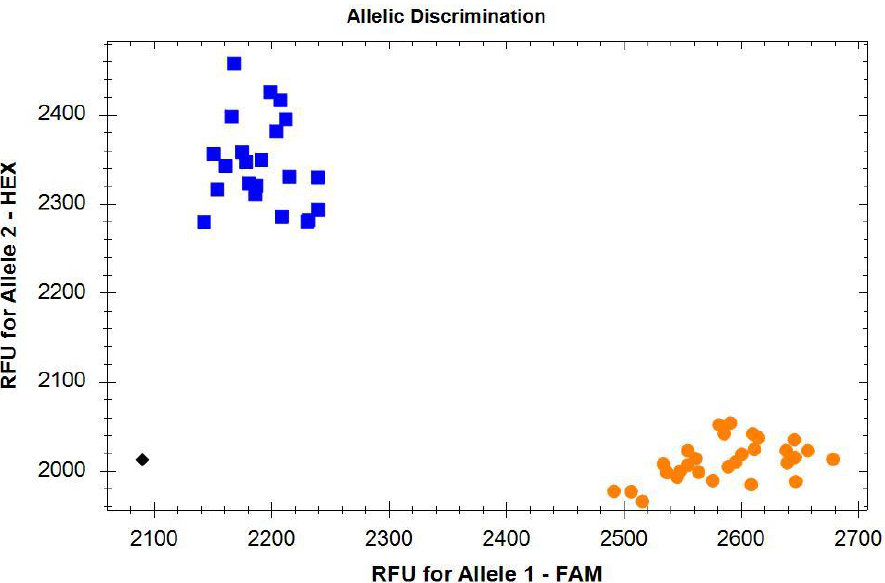
Figure 2. Application of KASP marker 1B1R_6110 for the detection of translocation 1RS.1BL. Blue squares (HEX axis), the presence of the 1RS.1BL translocation; orange circles (FAM axis), the absence of the 1RS.1BL translocation; the black rhombus in the lower left corner is the negative control (water). Application of both SCM9 and 1B1R_6110 markers did not reveal either 1RS.1BL